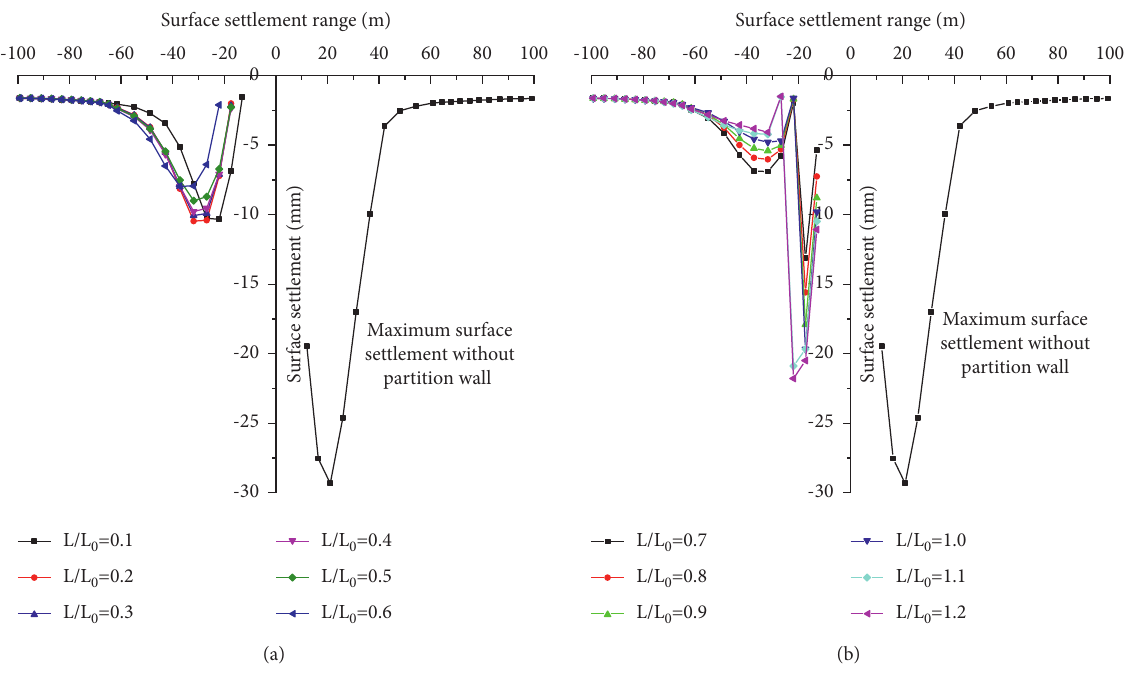
0 on the maximum ground settlement and the settlement form. (a)